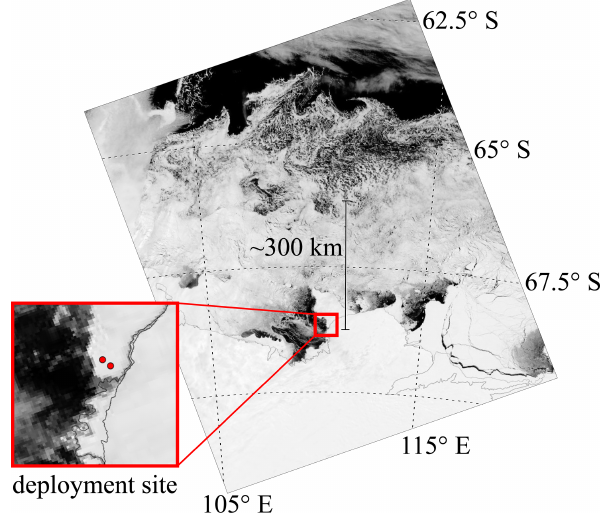
Figure 1. MODIS imagery (https://worldview.earthdata.nasa.gov/, last access: 7 May 2021) of the deployment site and sea ice on 10 November (end of deployment with clear sky). Instruments were deployed on landfast ice, and the site was separated from the South- ern Ocean open water by a vast stretch of pack ice throughout the